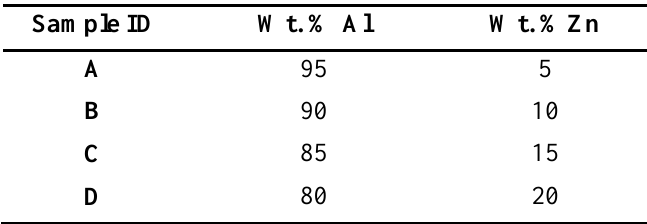
Table 1. Table headings are placed above the